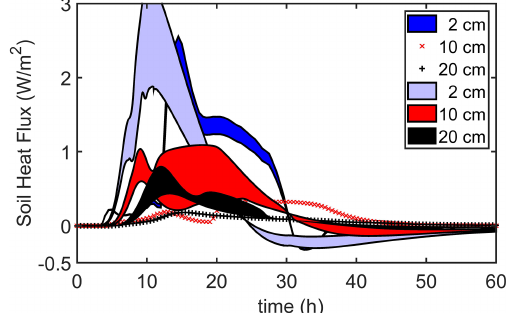
Figure 14. Potential impacts of dynamic feedbacks on the soil heat flux during the 26 April 2004 MEF burn. The observed data are shown as the (2cm) darker blue color-filled area and red and black symbols. The upper boundary of the observed heat flux includes the Philip correction, whereas the lower boundary of this region is the measured heat flux after applying the Philip correction. The Philip correction is not shown for the two lower heat flux measurements because it made virtually no difference to these measurements. The upper boundary of the light blue, red and black color-filled areas corresponds to the feedback simulation and the lower boundary to the base case